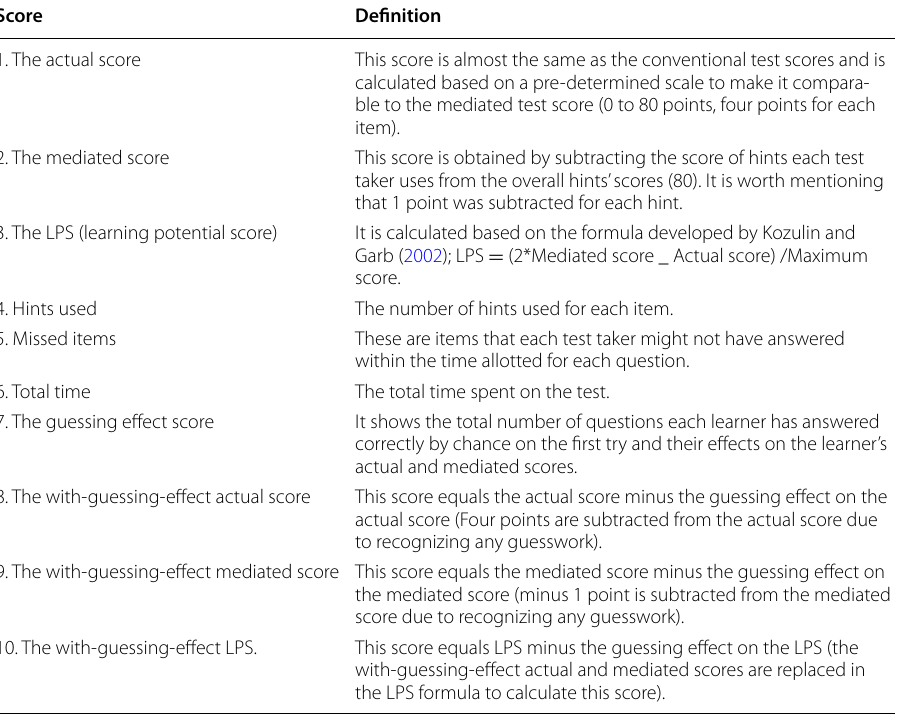
Table 1 The scoring profiles of learners generated by the dedicated website